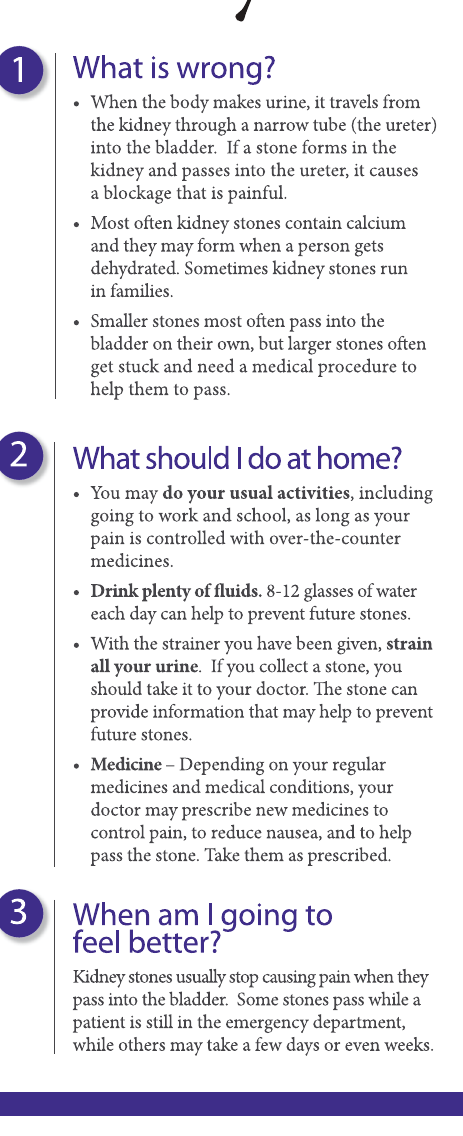
Figure 1: Revised kidney stone discharge